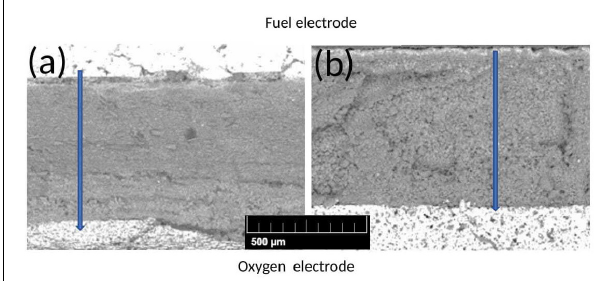
FIGURE 7 | SEM micrographs of the matrix cross-section in: (a) reverse MCFC cell and (b) reference test